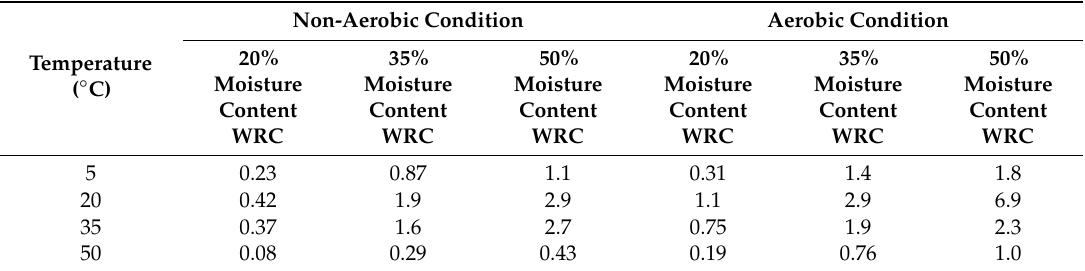
Table 1. Cumulative CO 2 emissions from stored WRC chips after storage tests (g / kg DM).